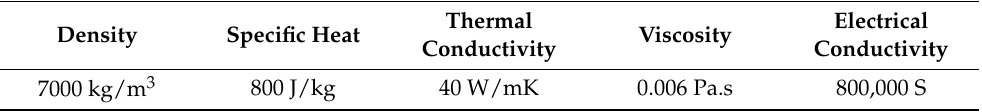
Table 1. Liquid metal